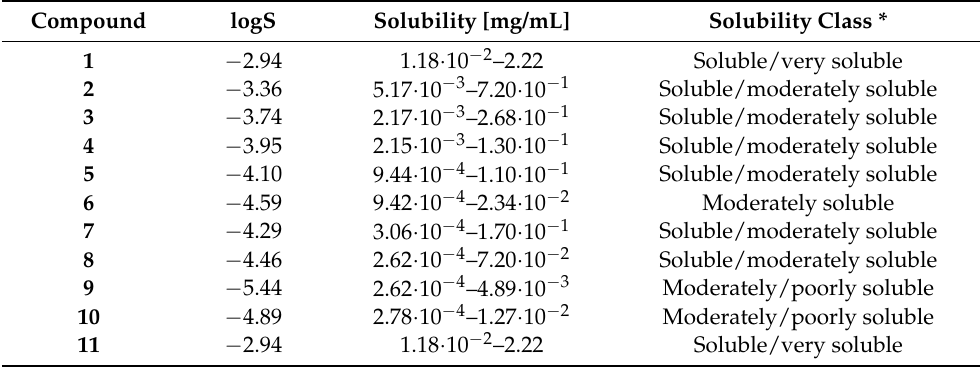
Table 6. Water solubility od derivatives 2 – 11 calculated in SwissADME. LogS in the table is the average value of logS calculated using three different methods. * Solubility class—logS scale: Insoluble < − 10, Poorly < − 6, Moderately < − 4, Soluble < − 2, Very < 0. Compound logS Solubility